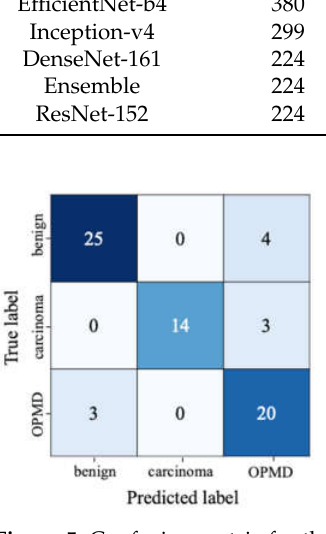
Model F 1 -Score